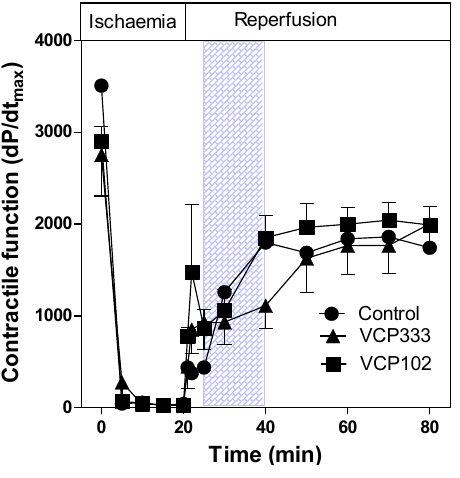
Figure 5. The effect of 15-min allosteric modulator VCP333 (1 μM) or VCP102 (10 μM) infusion on contractile function (dP/dt ) in mouse isolated hearts following 20-min of max global ischaemia. Values are mean ± SEM, n = 6–10 per group.